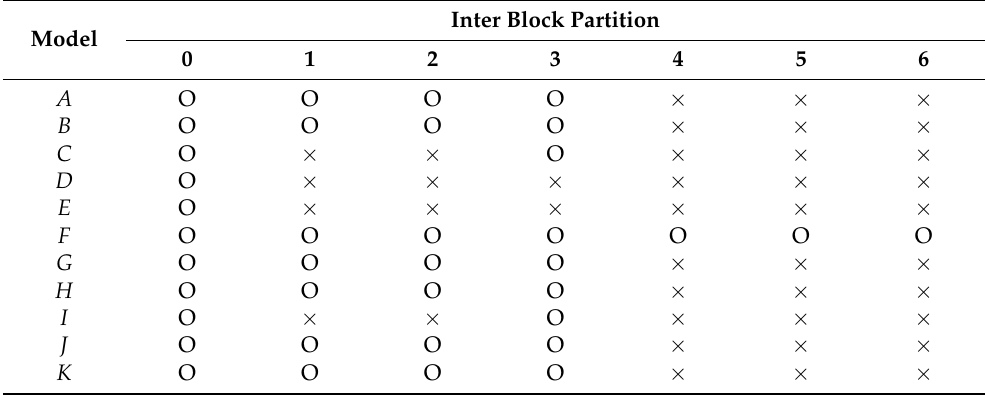
Table 15. Examples of inter block partitions in H.264 encoder’s descriptors. Here, O and × represent ‘used’ and ‘not used’, respectively. The numbers 0, 1, 2, 3, 4, 5, and 6 in inter block partitions denote